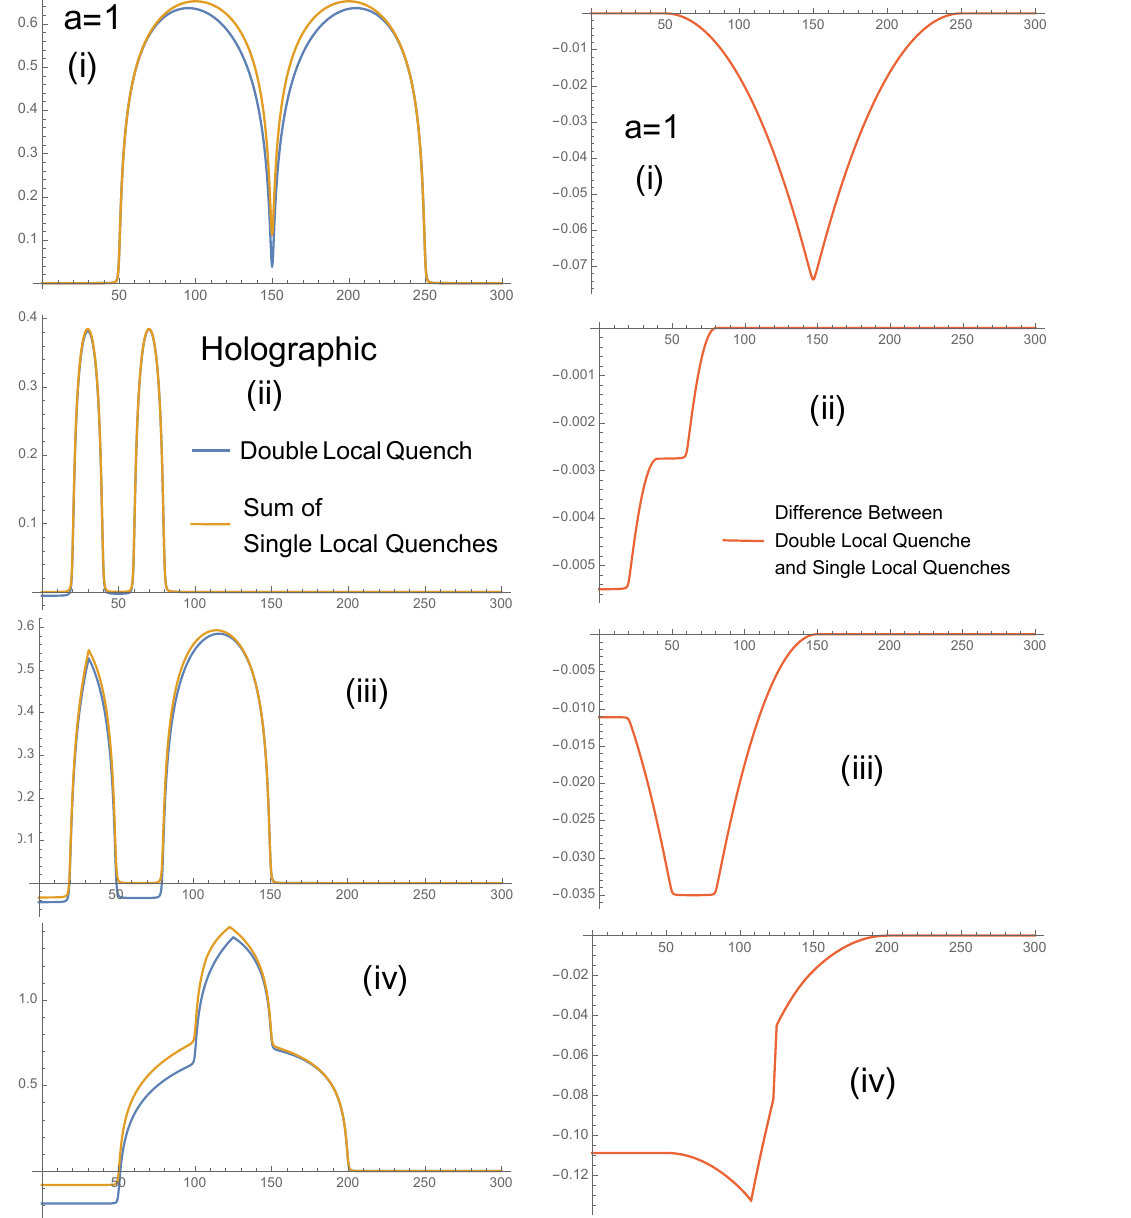
Figure 19 . The plots of the full HEE (cid:1) S D for the double joining local quench and the di(cid:11)erence A (cid:1) S D (cid:1) S S ( x = b ) (cid:1) S S ( x = (cid:0) b ) between the double and single quench as a function of t . We set A (cid:0) (cid:0) b = 50 and a = 1. From the top to bottom we presented results for the four di(cid:11)erent setups (i), (ii), (iii) and (iv). Left: the plot of the full HEE (cid:1) S A for the double local quench. Right: the plot of the di(cid:11)erence (cid:1) S D (cid:1) S S ( x = b ) (cid:1) S S ( x = (cid:0) b ) between double local quench and single local A (cid:0) A (cid:0) A quenches.